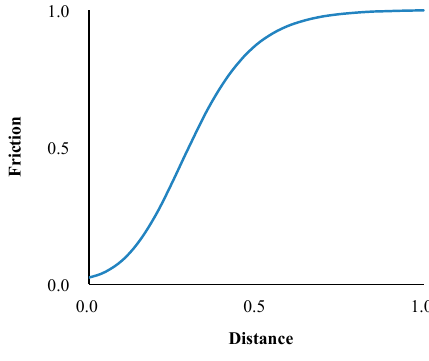
Figure 5. Optimized distance–friction curve.